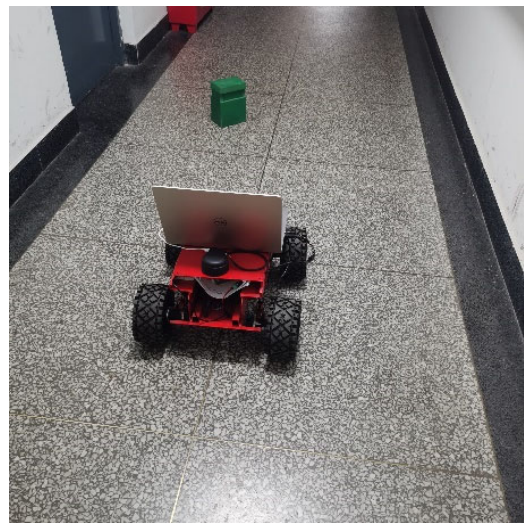
Figure 19. Four ‐ wheel robot. Figure 19. Four-wheel